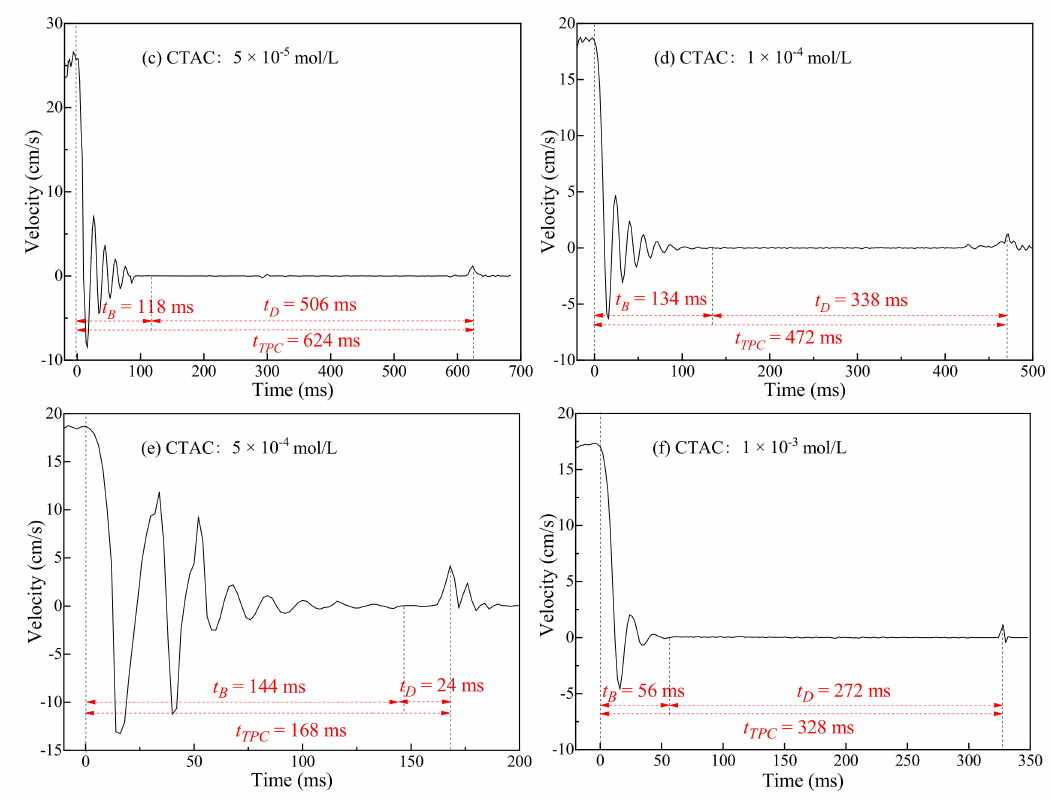
Figure 7. Bubble velocity variation during collision-rebound process with muscovite surface in CTAC solution with different concentrations. ( a ) 5 × 10 − 6 mol/L; ( b ) 1 × 10 − 5 mol/L; ( c ) 5 × 10 − 5